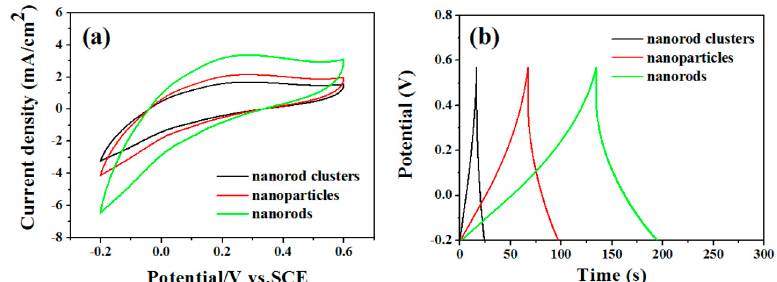
Figure 6. Electrochemical characterization of the MoO 3 nanowires, nanoparticles, and nanorod clusters. ( a ) Cyclic voltammograms at the same scan rates 5 V/s with the potential window from − 0.2 to +0.6 V and ( b ) Charge/discharge curves at the same current density 2 A/g.